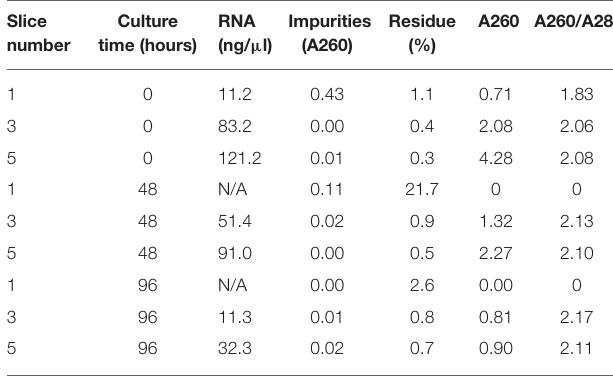
TABLE 1 | Yield and quality of RNA isolated from spleen slices (1, 3, or 5 slices/sample) immediately after cutting or cultured for either 48 or 96